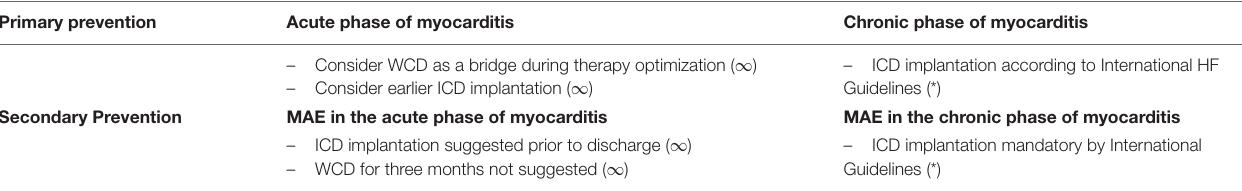
TABLE 3 | Primary and secondary ICD prevention indications according to the clinical scenario of